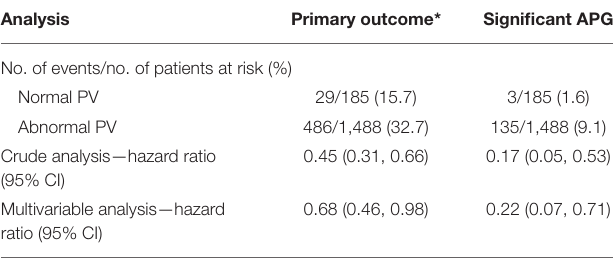
TABLE 3 | Association between pulmonary valve morphology and follow-up outcomes in the crude analysis and multivariable analysis.